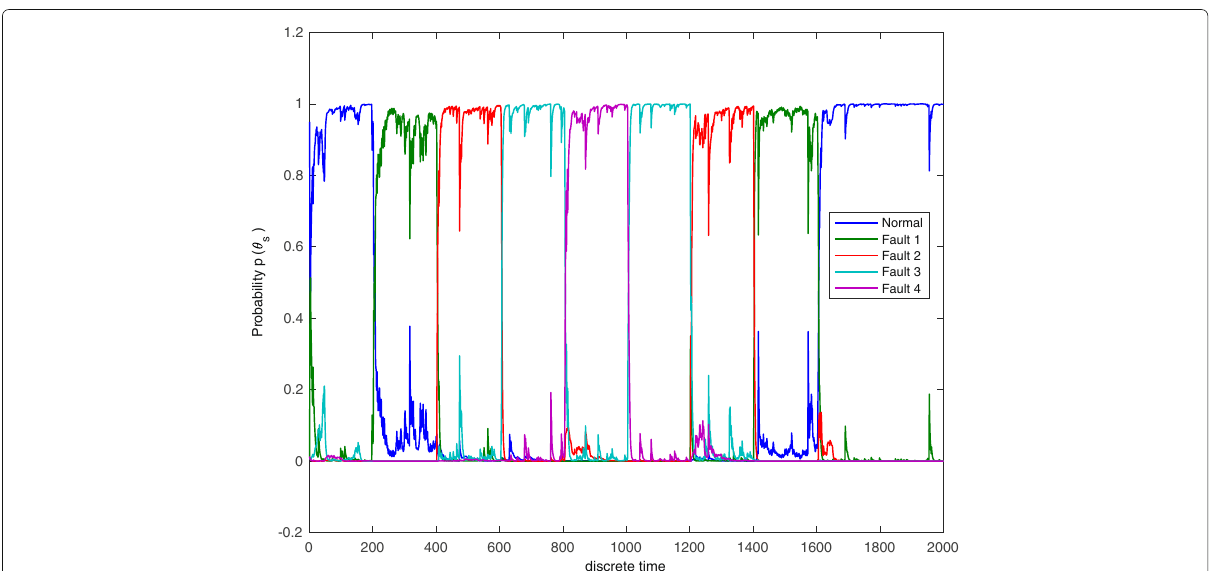
Fig. 2 Probability of which operation state system (45) is in conditional on the measurements. Probabilities are computed using formula (29)